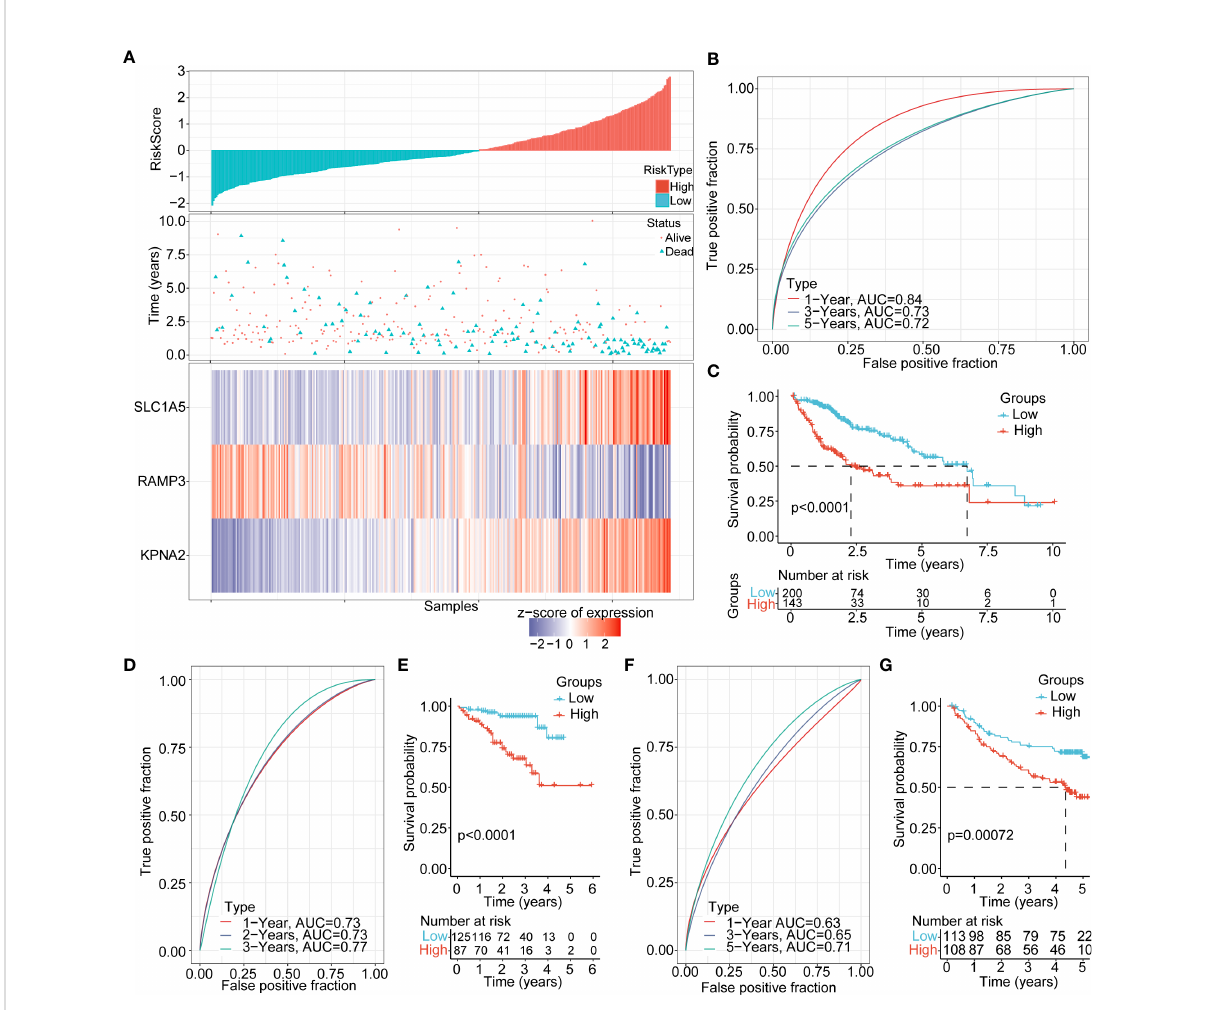
FIGURE 6 Clinical features and prognosis evaluation between the high and low risk-score subgroups (A) The risk score, living status, and expression landscape of 3 genes (SLC1A5, RAMP3, and KPNA2) in the TCGA-LIHC cohort. (B) Prognosis prediction model based on the 1-year, 3-year and 5-year AUC curves of these 3 genes (SLC1A5, RAMP3, and KPNA2). (C) Overall survival curves between the high and low risk-score subgroups in the TCGA-LIHC cohort (D − G) . AUC curves and KM curve of different risk scores between different clinicopathological subgroups in ICGC,